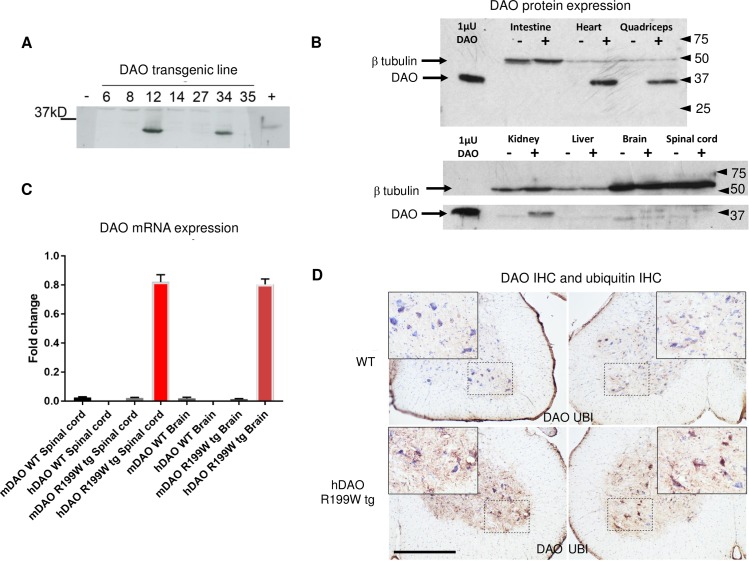
Transgene expression in two mouse lines (A), regional tissue expression of DAO protein (B) and mRNA (C) in DAOR199W
transgenic mice and immunohistochemical localisation of DAO and ubiquitin in DAOR199W
Transgenic mice (D). A. Expression of DAO in spinal cord from two DAOR199W
lines. Western blot analysis of different transgenic mouse lines expressing human DAO. 200ng of spinal cord from each animal was separated by SDS-PAGE and blotted with anti-DAO antibody. Expression of DAO was present in two DAOR199W transgenic mice lines, 12 and 34 (used in the survival analysis). A porcine DAO protein standard (indicated by a + sign) was loaded in the final well. B. Regional expression of DAO protein in DAOR199W
transgenic mice. The highest concentrations of DAO (37kDa) in DAOR199W transgenic mice (indicated by +) were found in heart and quadriceps muscle (upper panel), followed by kidney, spinal cord, brain (lower panel) and in both lines (shown here for line 34) compared to wild-type mice (indicated by a -). Lower levels were found in liver and small intestine. The loading control was beta tubulin (50kDa). DAO immunoreactivity was low in non-transgenic mice. C. Regional expression of DAO mRNA in DAOR199W
transgenic mice. Expression of human DAO (hDAO) and mouse DAO (mDAO) in spinal cord, brain and quadriceps muscle from wild-type (WT) and DAOR199W transgenic mice (R199W tg). D. Spinal cord expression of DAO and ubiquitin in DAOR199W
Transgenic mice. Lumbar spinal cord sections (L2-L4) from 8 month old non-transgenic and R199W DAO tg mice were immunostained for DAO and ubiquitin and counterstained with Nissl (blue). Ventral horns with their enlargement (boxed area) are shown for each section. Spinal cord sections from the DAOR199W transgenic showed widespread distribution of DAO staining (brown) throughout the ventral grey matter (lower left hand panel) particularly in dendrites and interneurons with lower levels present in non-transgenic littermates (upper left hand panel). Similarly, ubiquitin staining was more intense in sections from DAOR199W transgenic mice (lower right hand panel) compared to their non-transgenic littermates (upper right hand panel). Scale bar, 500um.